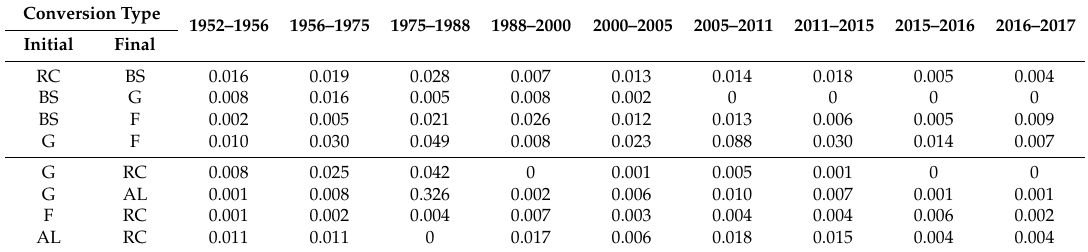
Table 2. Conversion matrix (changes in percent) of LC categories in the investigated periods.